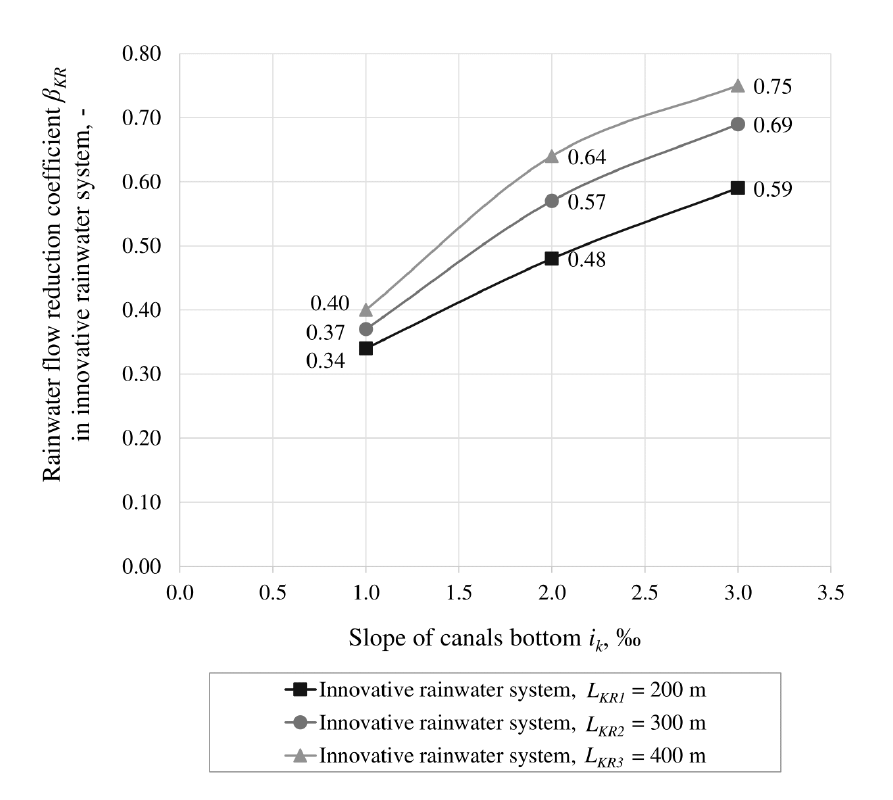
in innovative rainwater system for different slopes of canals i KR